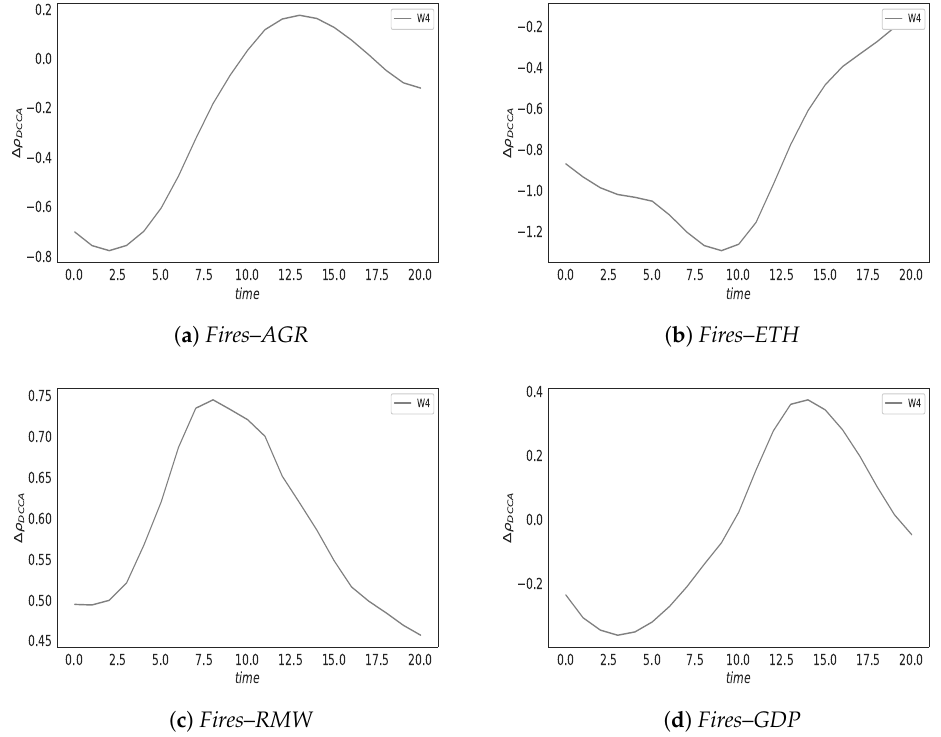
Figure A7. The ∆ ρ dcca for the different TS pairs and time scale n =